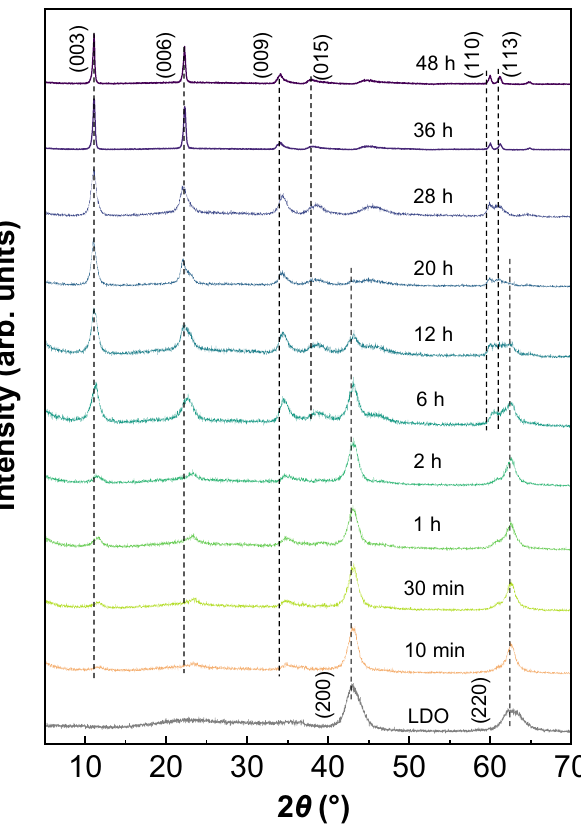
Fig. 3 | Ex-situ XRD patterns of rehydrated Mg/Al-LDO. XRD patterns of the resulting solids after mixing Mg/Al-LDO with NaNO 3 solution in D 2 O during a conventional recovery process (mass ratio of Mg/Al-LDO to D 2 O is ~1:100) for a speci fi c rehydration time t (10min to